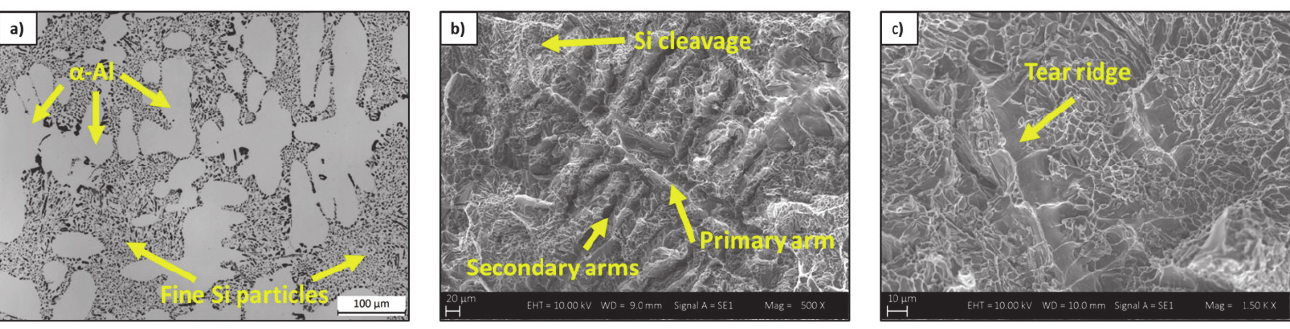
Figure 9: HIP 50 treated specimen: (a) microstructure at high magnification by optical microscopy; (b-c) fracture surface by scanning electron